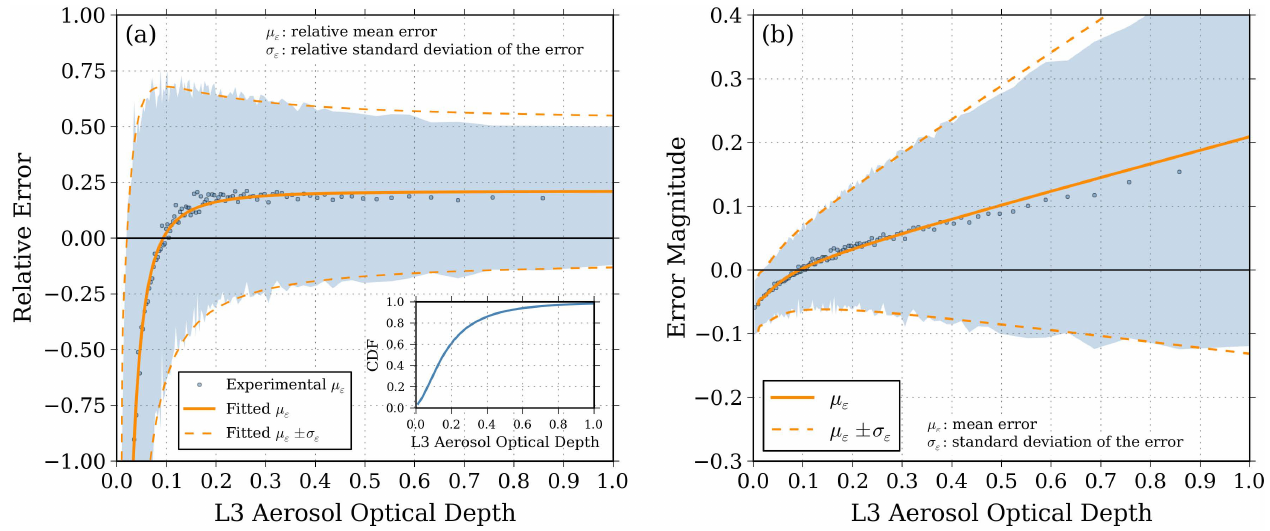
Fig. 5. (a) Relative mean error (L3 AOD minus AERONET AOD) for the whole dataset (blue dots), and uncertainty range as relative mean error plus or minus one relative standard deviation of the error (dashed area). (b) Same as (a) but now the mean error and uncertainty are given in AOD unit. The orange lines are the fitted curves using Eq. (1). Coefficients for the “Globe” region are given in Tables A1 and